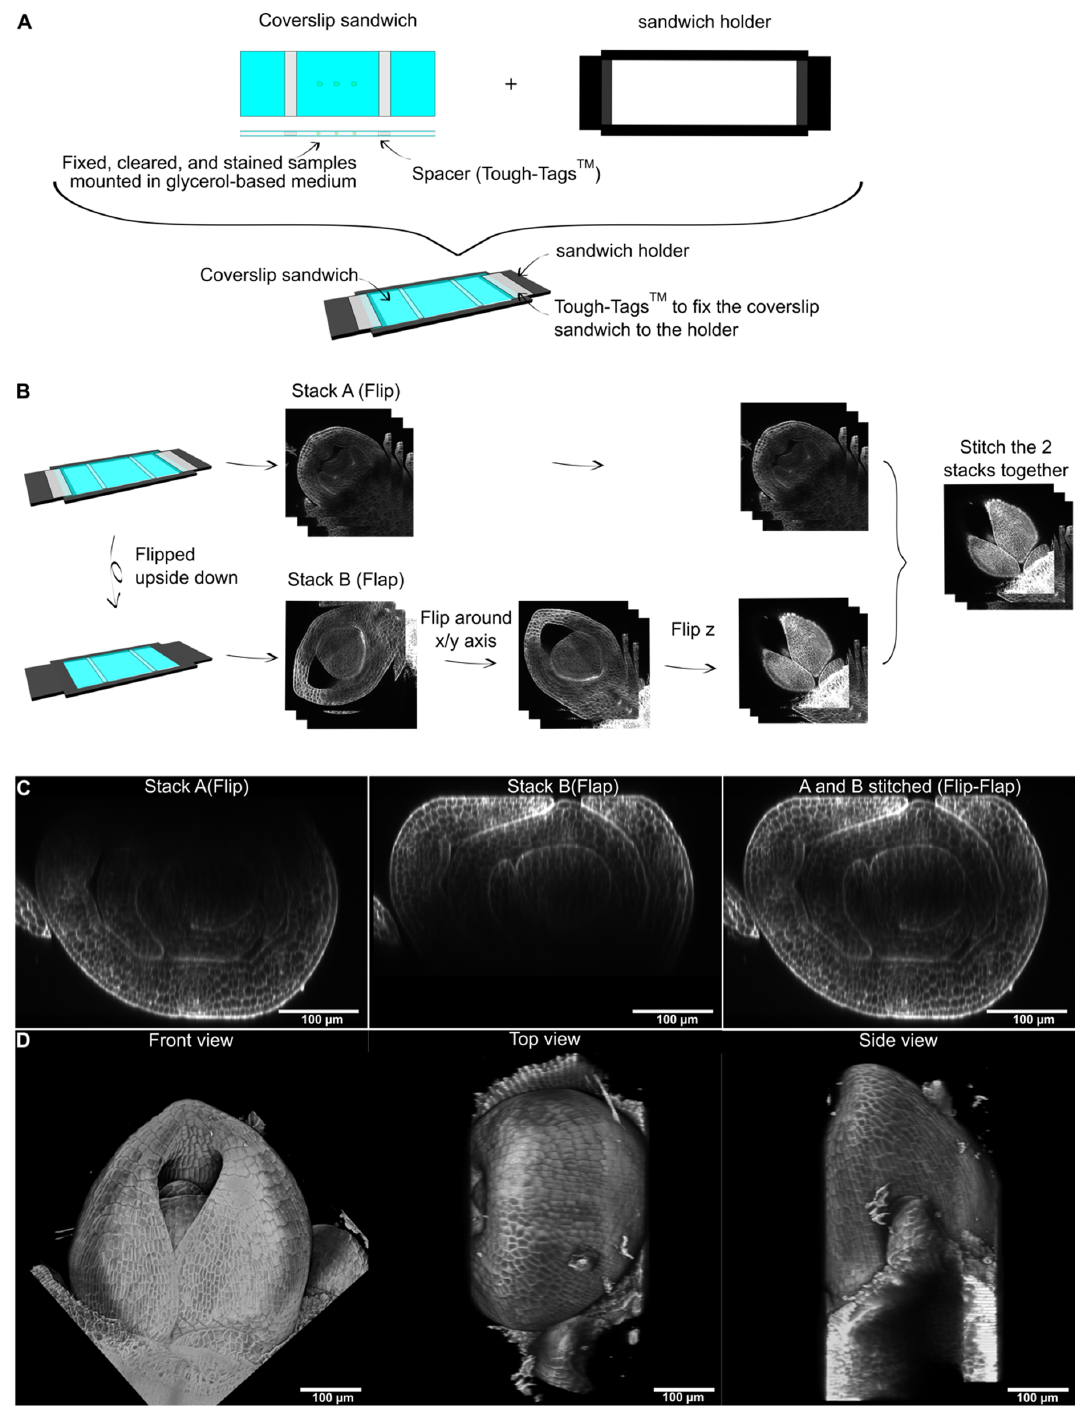
Figure 1. Description of the Flip-Flap method for 3D reconstruction of plant samples. ( A ) Fixed, cleared, and stained samples are mounted between two coverslips in a glycerol-based medium with spacers to prevent the sample from being squashed (coverslip sandwich). This mount is then attached to a 3D-printed holder (sandwich holder). ( B ) The mount is imaged from both sides using a laser scanning confocal microscope (LSCM) to produce two z series (Stack A/Flip and Stack B/Flap). Stack B is then rotated around the x or y axis, and the z order is inverted, before sticking Stack A to Stack B to produce the full 3D image. ( C ) Transverse optical section through Flip, Flap, and a stitched image of a barley shoot apex stained with calcofluor. ( D ) Front, top, and side view of the 3D reconstructed apex. Scale bars: 100 µ